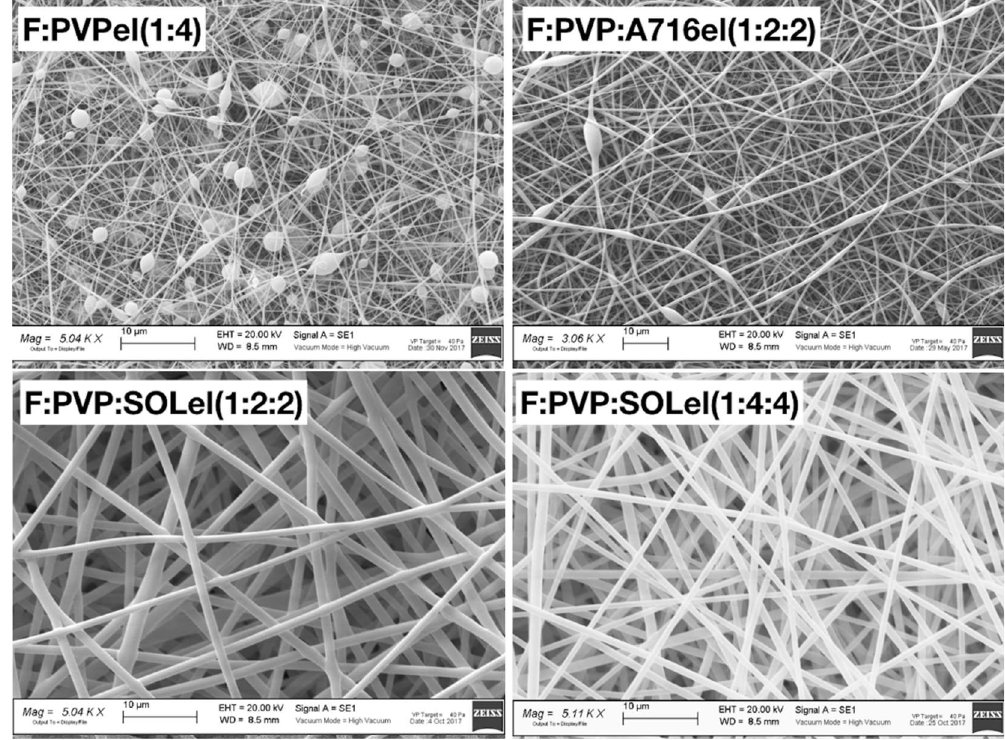
Figure 2. SEM micrographs of the polymeric fibers loaded with firocoxib.